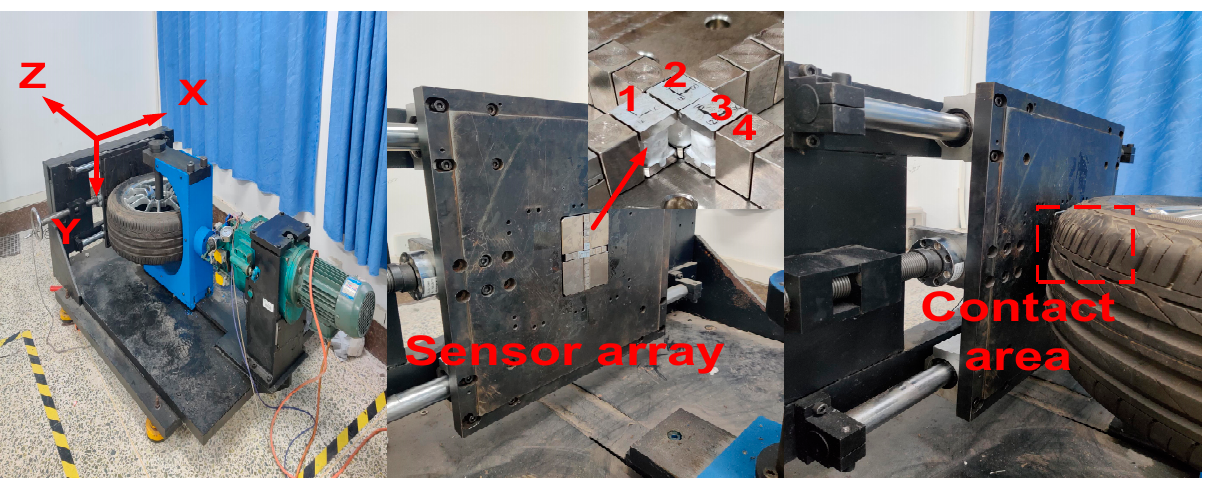
Figure 8. Simulated tire–pavement contact load test platform.